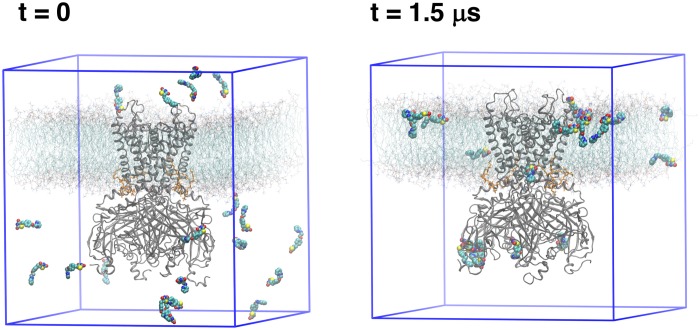
Simulation setups: The first and last frame of free MD simulation. Protein (gray cartoon) is embedded in the lipid bilayer (cyan lines with red head groups). As a starting simulation setup (t = 0), 20 ligands (shown as spheres) were randomly distributed in the solvent. After a 1.5 μs MD simulation, the ligands either are bound to the protein or entered the lipid phase.